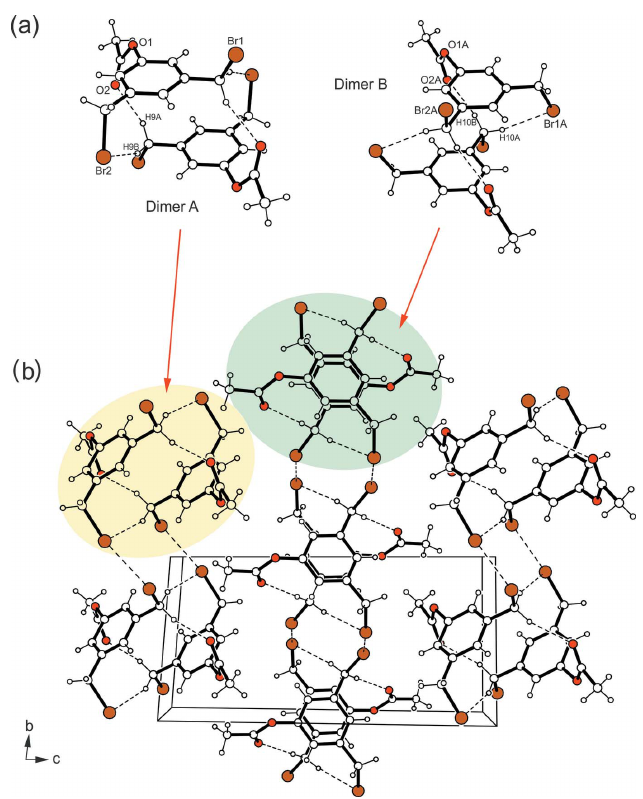
Figure 6 ( a ) Structures of the dimers formed by molecule A (left) and molecule B (right) in the crystal structure of 2 . ( b ) Packing structure of 2 viewed down the a -axis. Hydrogen bonds and Br (cid:2)(cid:2)(cid:2) Br interactions are shown as dashed lines.